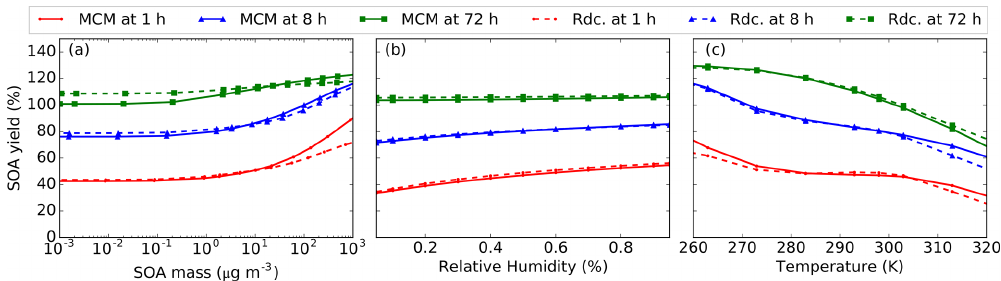
Figure 11. Dependence of the average SOA yield simulated by the pre-testing dataset with MCM (solid line) and the Rdc. mechanism (dashed line) on (a) BCARY SOA mass; (b) relative humidity (RH); and (c) temperature at 1h (red points), 8h (blue triangles), and 72h (green